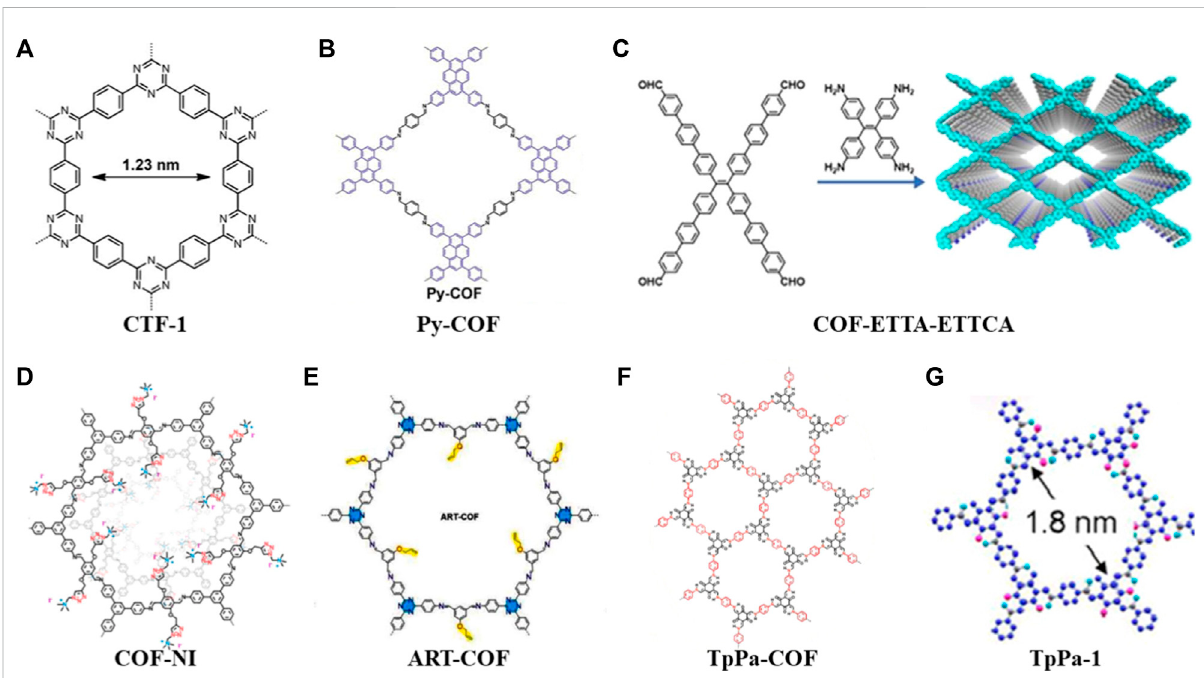
FIGURE 1 Summary of schematic diagram of the COFs in cathode materials (A – G) (Liao et al., 2014; Meng et al., 2018; Zhang et al., 2018; Lu et al., 2020; Wang et al., 2021; Li et al., 2022; Lin et al.,